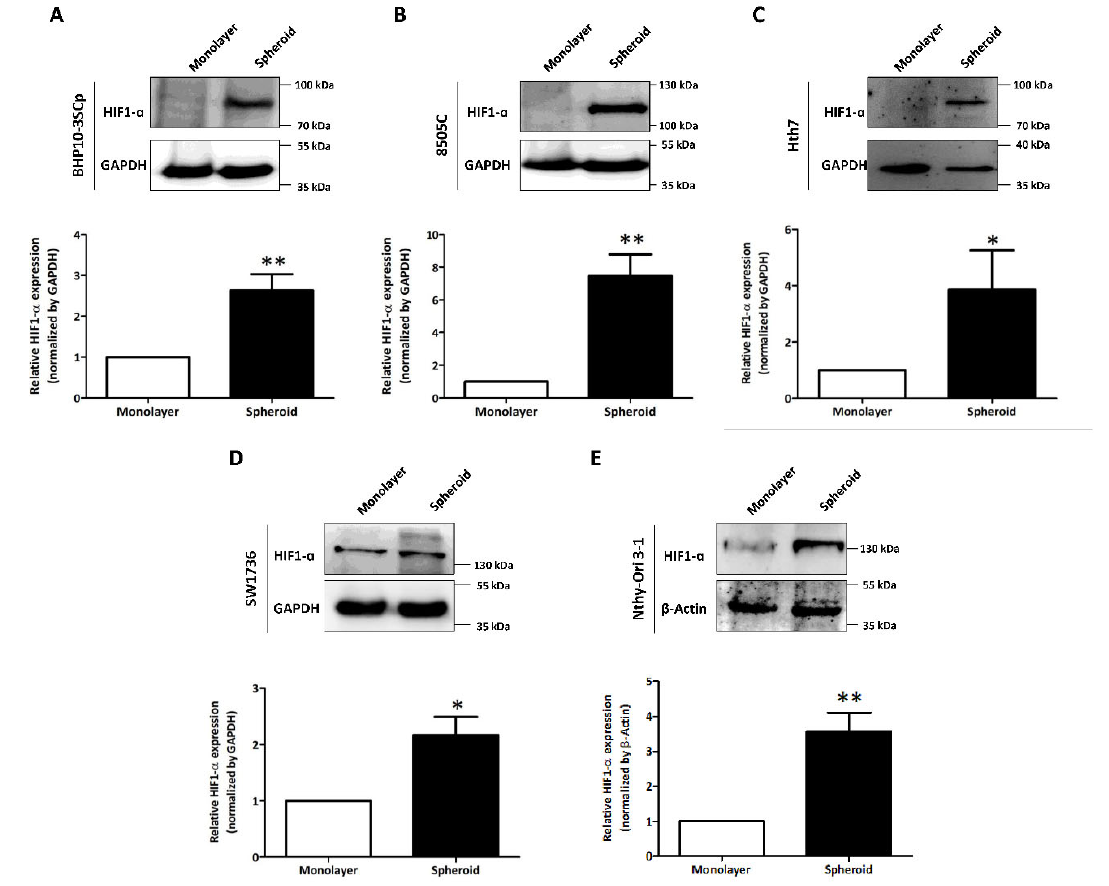
Figure 5. Investigation of hypoxia ‐ inducible factor 1 ‐α (HIF1 ‐α ) under the 2D monolayer and 3D spheroid condition. ( A ) Papillary thyroid cancer cell line (BHP10 ‐ 3SCp). ( B – D ) Anaplastic thyroid cancer cell lines ‐ ( B ) 8505C, ( C ), Hth7 (D) SW1736. ( E ) Thyroid follicular epithelial cell line (Nthy ‐